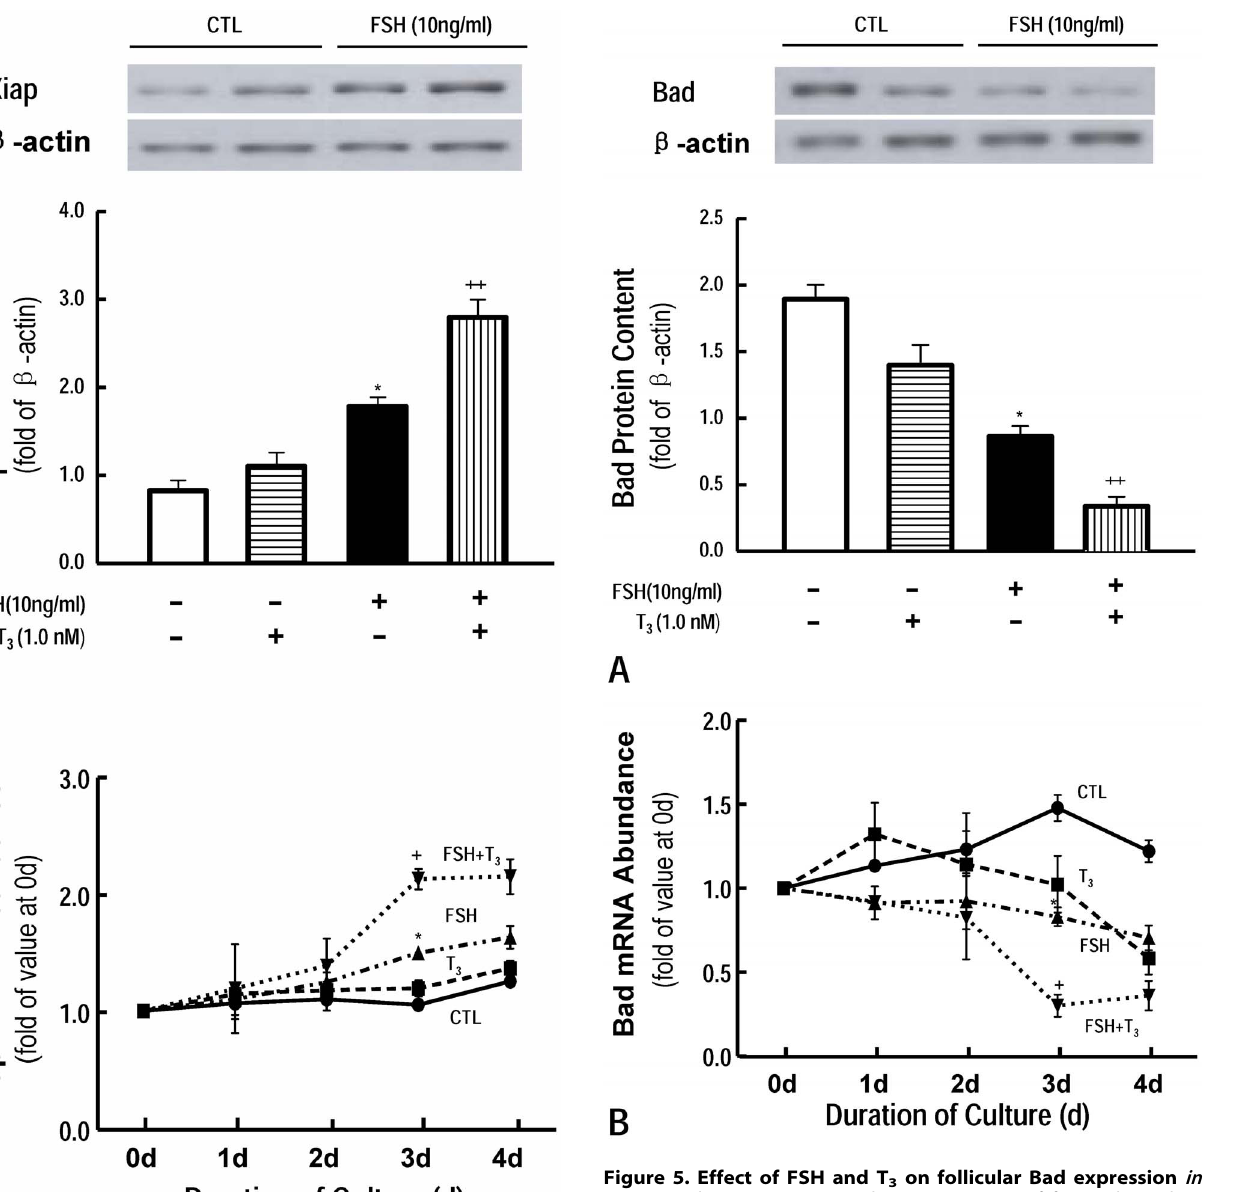
Figure 5. Effect of FSH and T 3 on follicular Bad expression in vitro . Results were represented as means 6 SEM of four independent experiments. FSH significantly down-regualted Bad expression (P , 0.05), the down-regulation effect was dramatically enhanced by T 3 (P , 0.01) although T 3 alone was ineffective. *: P , 0.05 vs CTL; + , P , 0.05; ++ , P , 0.01 vs FSH (Two way ANOVA).